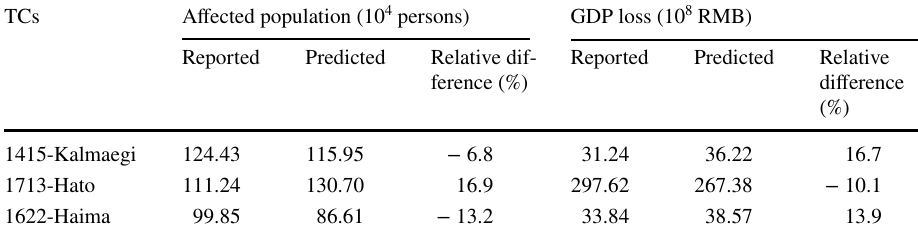
Table 2 Comparison of disaster losses between reports and simulations in the affected counties for tropical cyclone (TC) Kalmaegi (1415), Hato (1713), and Haima